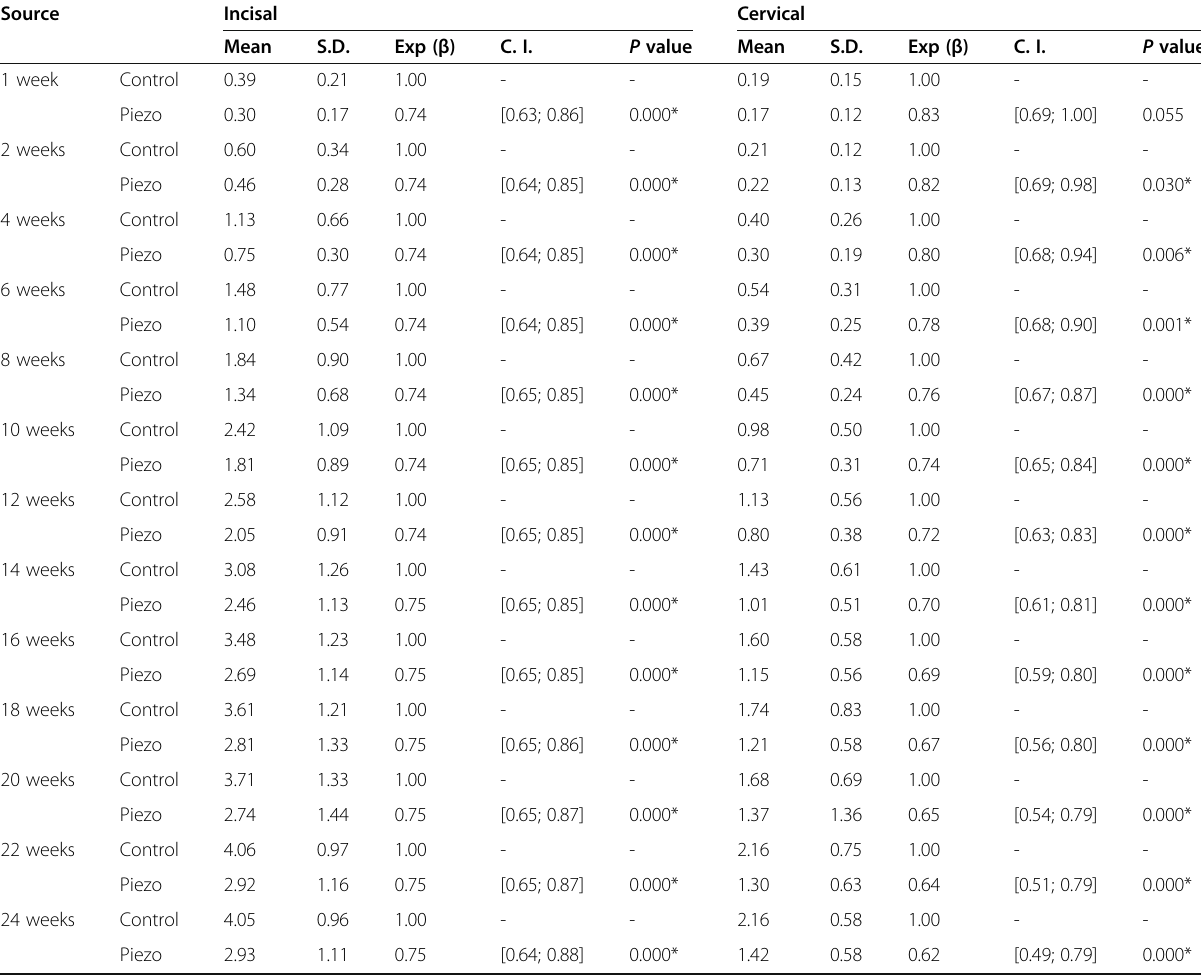
Table 3 Comparison of incisal and cervical accumulative moved distances (mm) between sides over time - group 2 Source